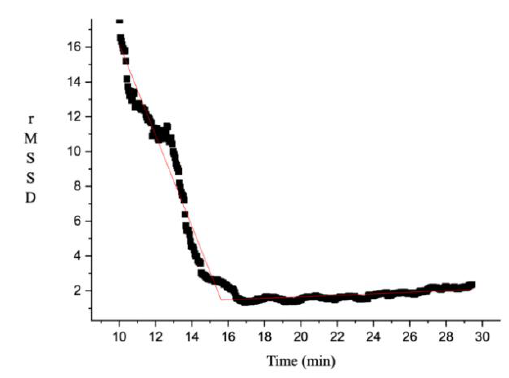
Figure 1. Example of a pairwise bilinear fitting function used to evaluate the heart rate variability threshold (HRVT). This analysis consists of two linear segments (solid red lines; R-squared = 0.98) used to perform a fit of the root mean square of the standard deviation of R–R intervals (RMSSD) moving average data (black marks) to calculate the intersection location for two linear segments from the fitting result.